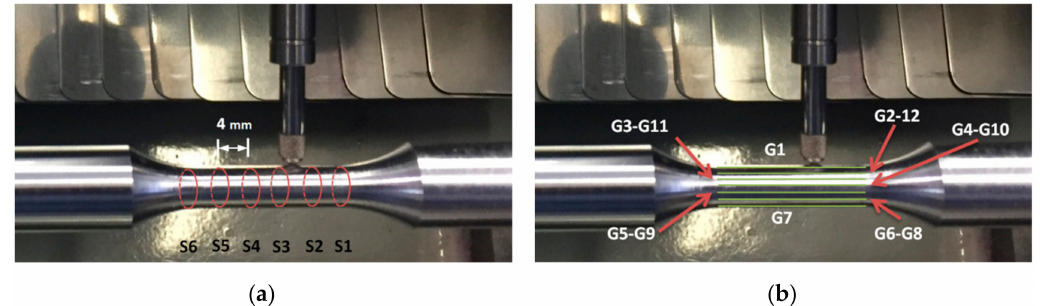
Figure 5. ( a ) The roundness (RON), circular run-out (CRO) and concentricity (CON) measured sections; ( b ) straightness (STR) and parallelism (PAR) measured